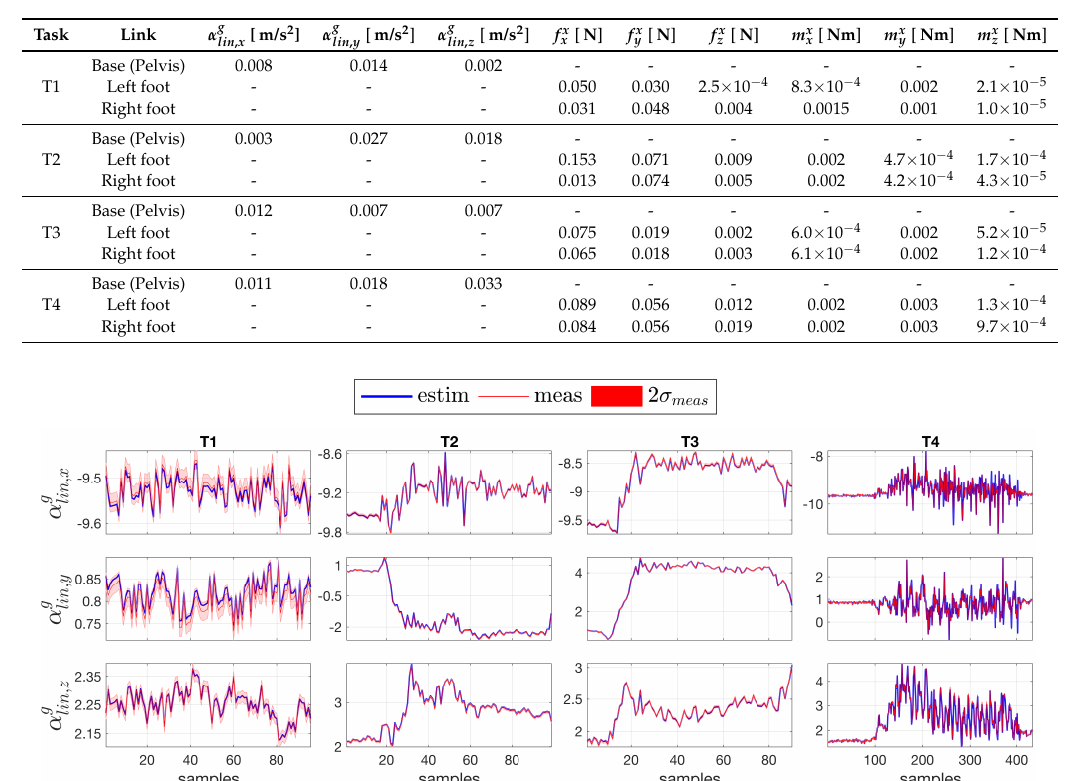
[ m/s 2 ], the external force f x lin